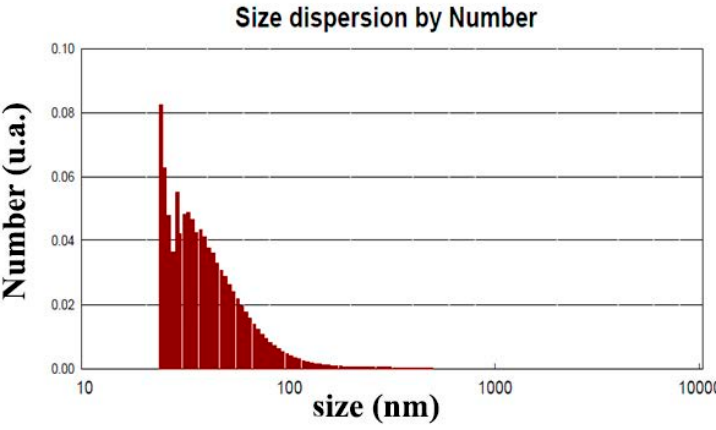
Figure 2. PSA (Particle Size Analysis) of SiC nano powders.